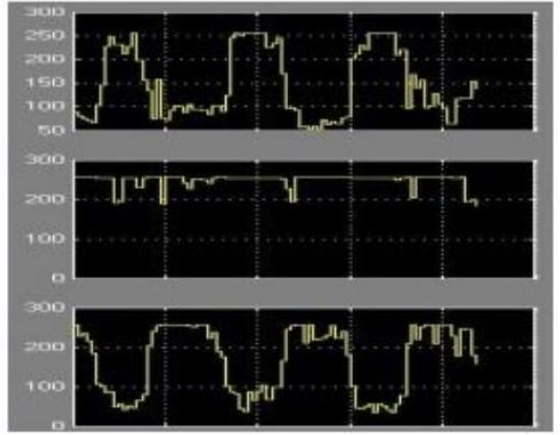
Figure 5: Voltage levels for bending of fingers.